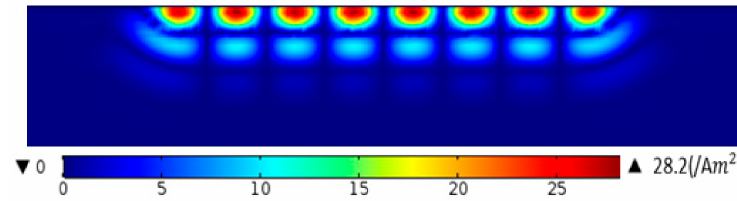
Figure 12. Eddy current distribution in aluminum plate before adding ANSM.